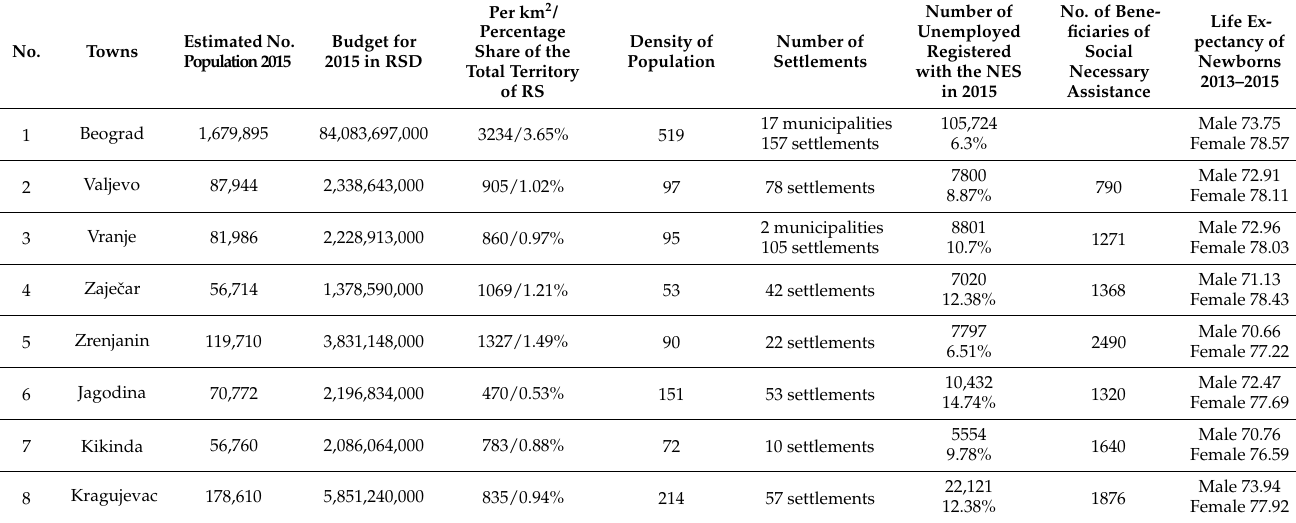
Table A2. An overview of socioeconomic and health indicators (2017)